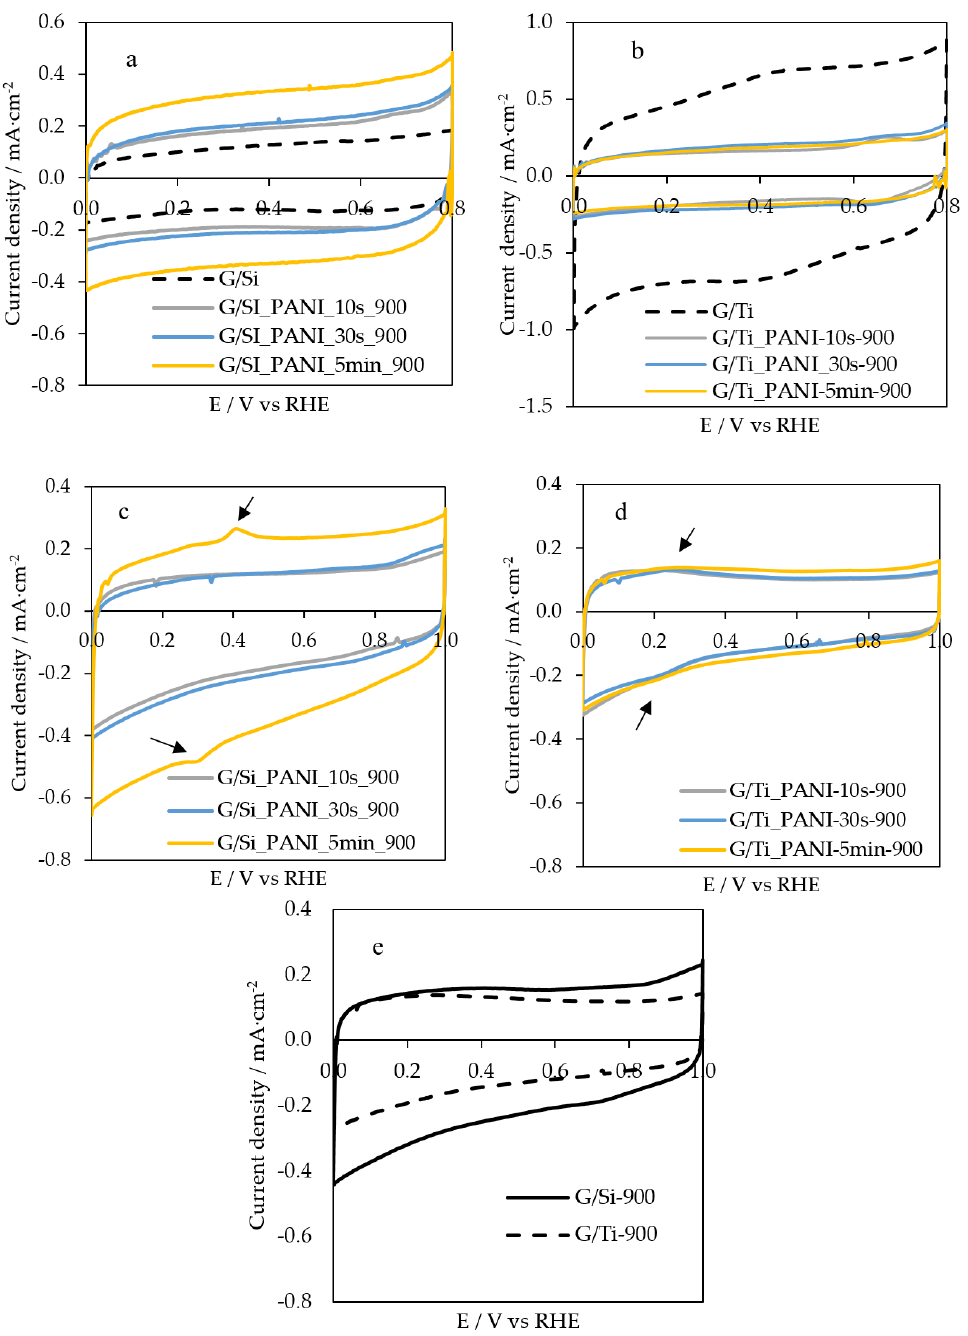
Figure 2. CV profiles of ( a ) G/Si-PANI-5min and ( b ) G/Ti-PANI-5min after the heat treatment in 0.1 M H 2 SO 4 solution. CV profiles of the heat-treated ( c ) G/Si-PANI_X_900, ( d ) G/Ti-PANI-X-900, and ( e ) G/Si-900 and G/Ti-900 samples in 0.1 M KOH solution. Scan rate = 50 mV·s −1